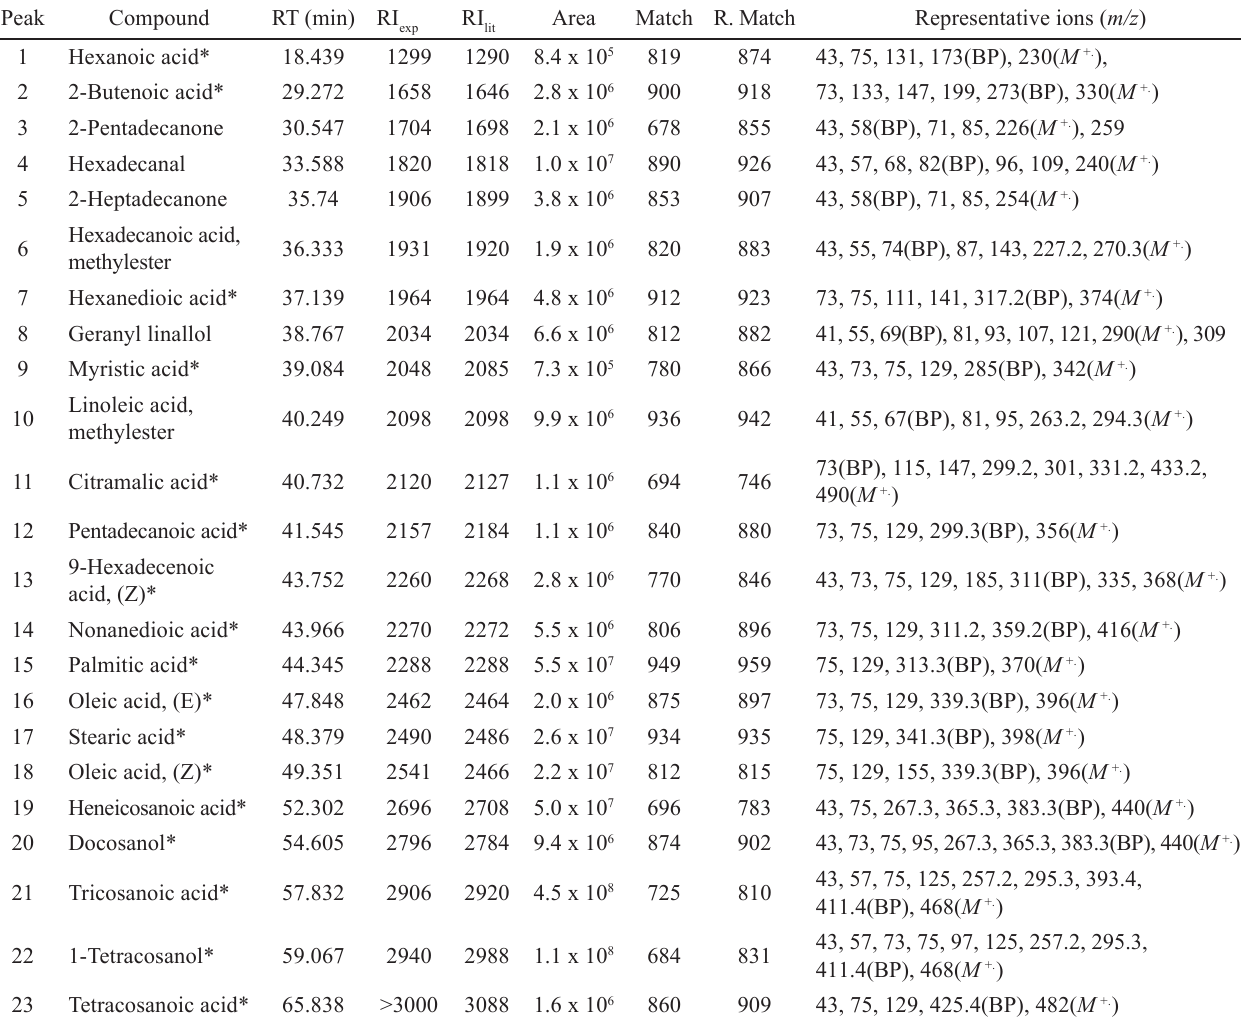
Table 1 . Chemical compounds identified in oils collected from nance (Byrsonima sericea) flowers, with their respective retention times (RT in min), retention indices (experimental and from the literature) (RI), relative areas and representative ions (m/z). RT = Retention time; RI_exp = experimental linear retention index; RI_lit = retention index found in the literature; *compounds derived from TMS.